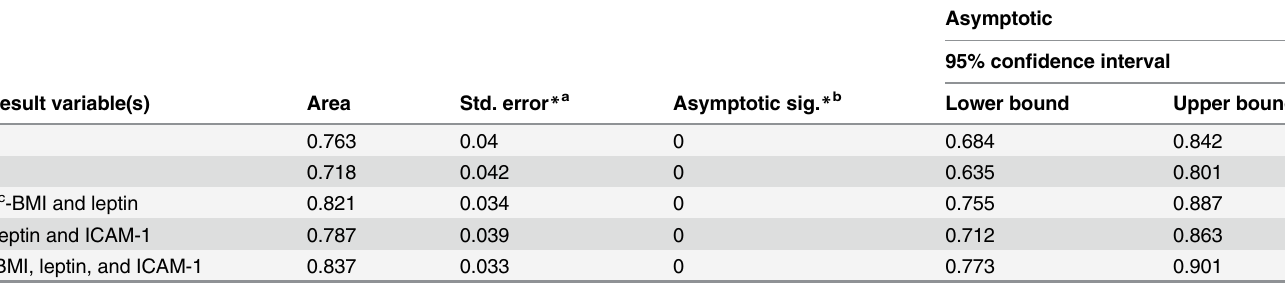
Table 5. AUCs of the ROCs and 95% confidence intervals for leptin and ICAM-1 in the differential diagnosis of SA and